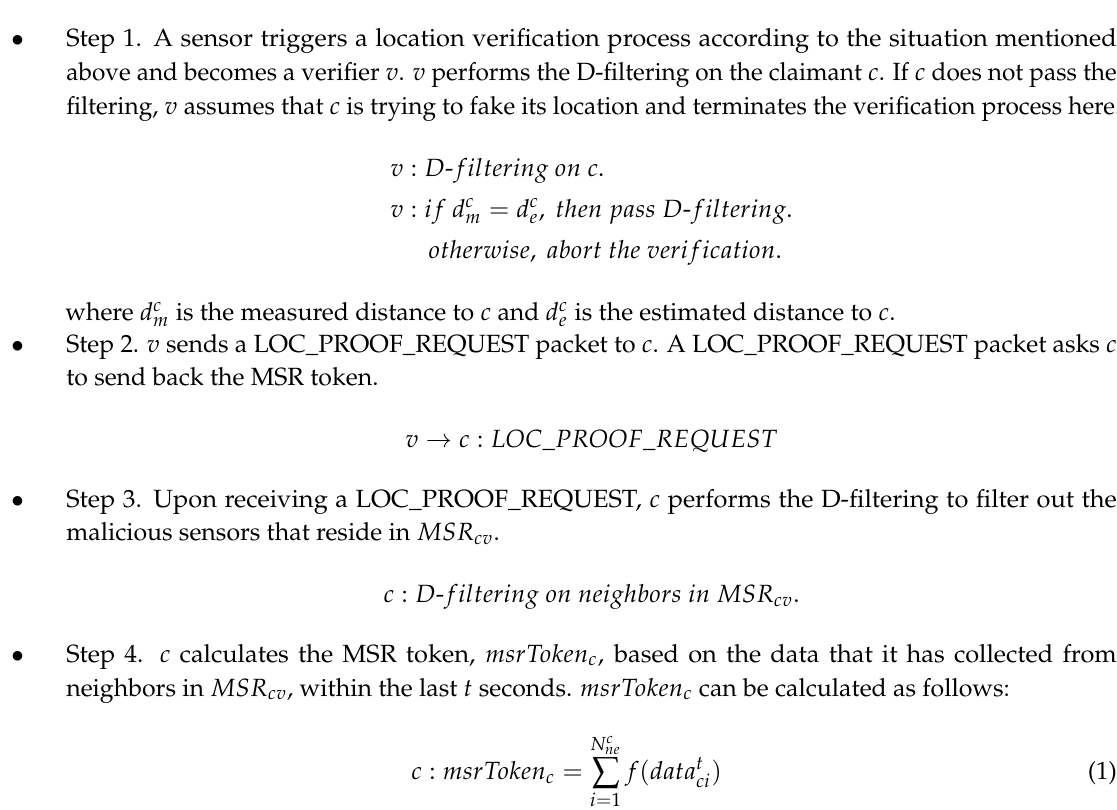
Figure 4. The mutually-shared region-based location verification (MSRLV)